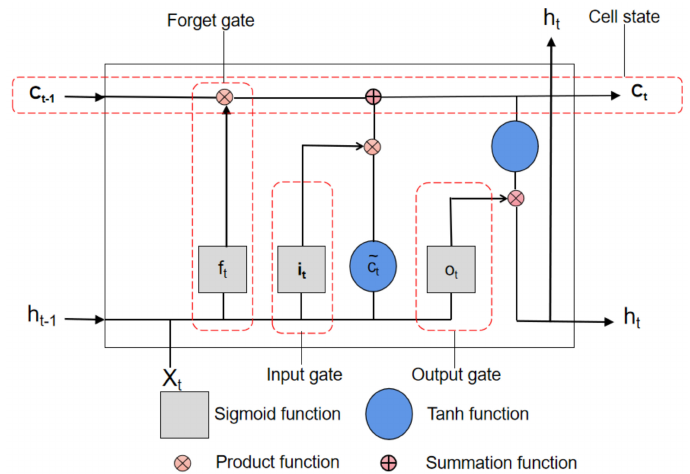
Figure 13. The architecture of a traditional LSTM